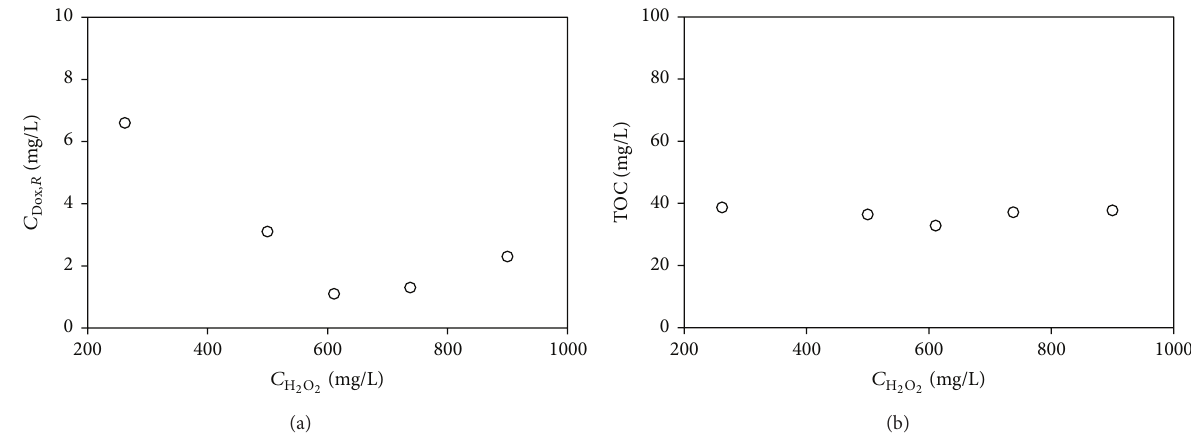
Figure 3: Influence of initial hydrogen peroxide concentration ( 𝐶 organic carbon (TOC) at the end of the Fenton process.